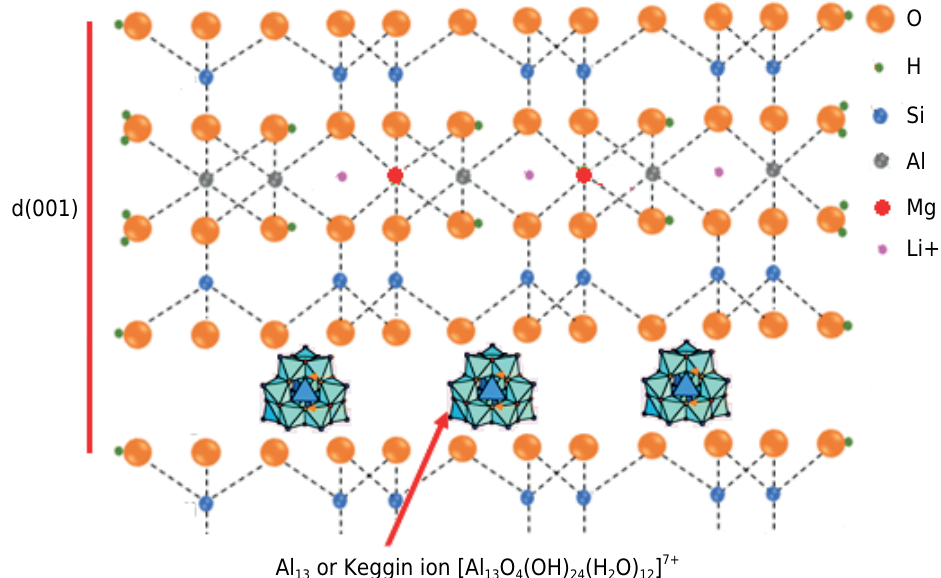
Figure 2. Schematic representation of basic 2:1 layer of montmorillonite (Mt) (isomorphic substitution of Al 3+ for Mg 2+ in the octahedral sheet), Al-pillarized (AlPEG, Al14h, and Al0h) and saturated with Li + (AlPEGLi, Al14hLi, and